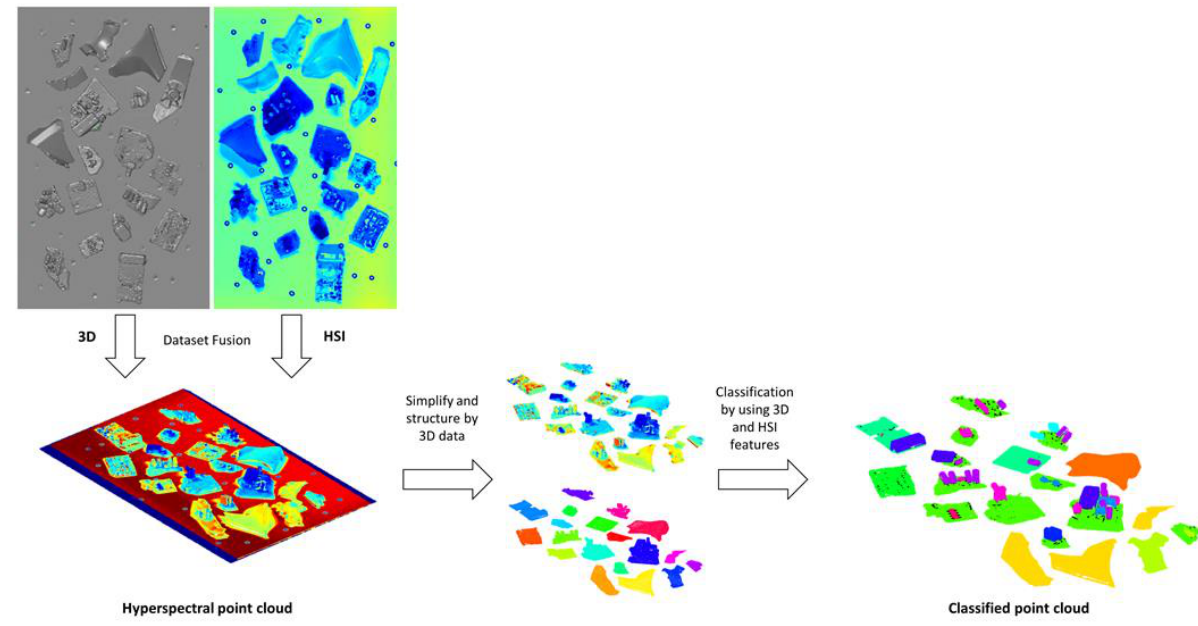
Figure 1. Workflow consisting of fusion, simplifying and classification steps.